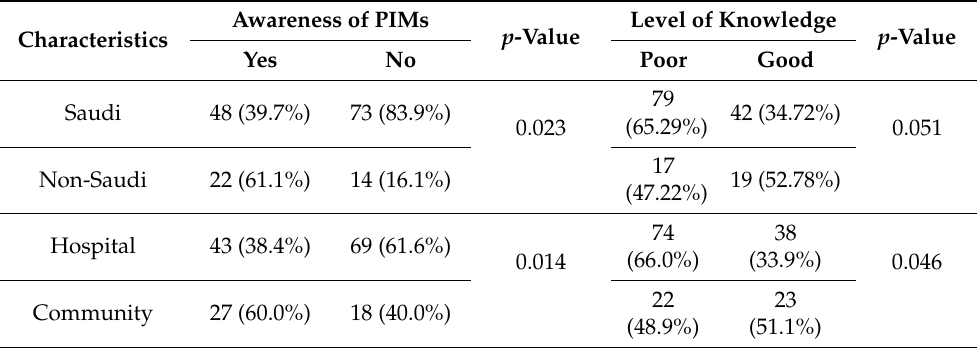
Table 2. Pharmacists’ knowledge and awareness about PIMs with the consideration of ethnicity and work